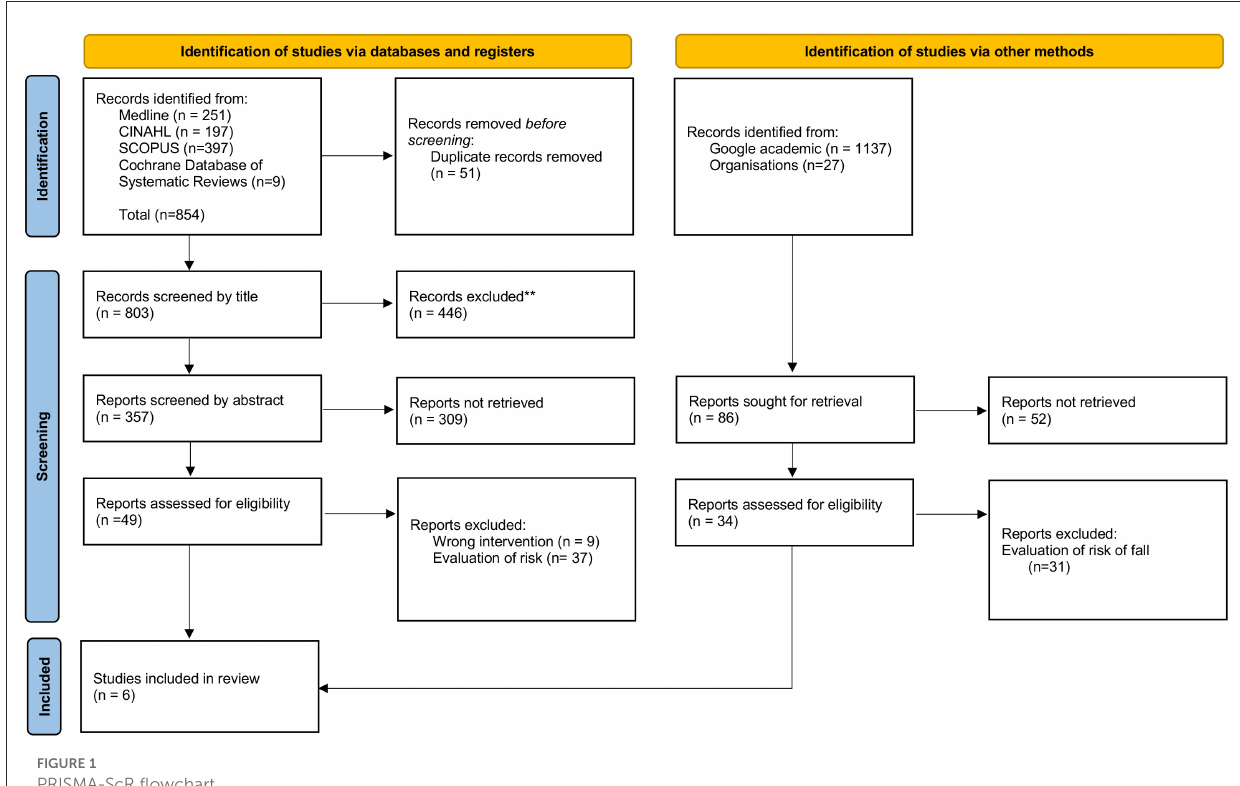
FIGURE1 PRISMA-ScR